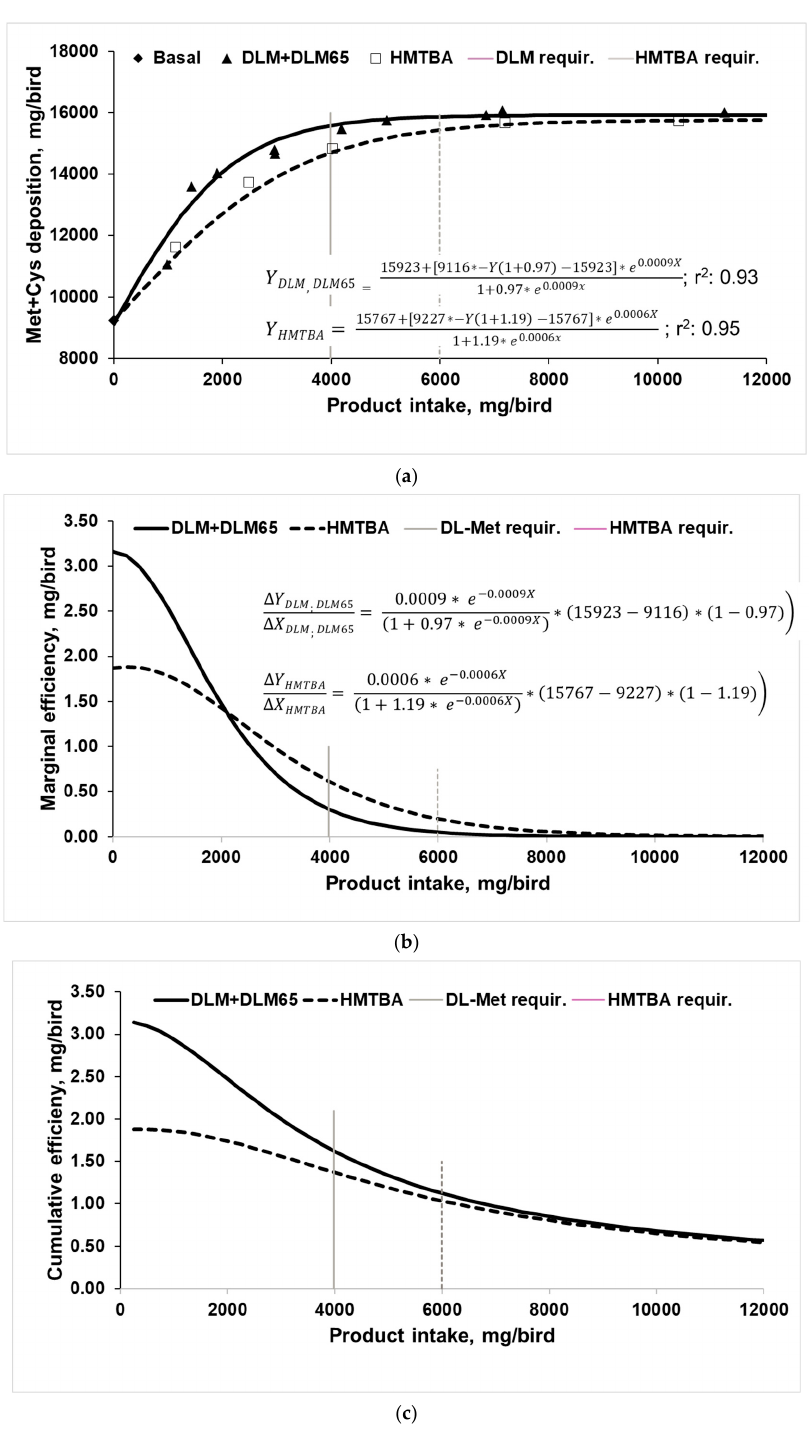
Figure 2. ( a ) Methionine + Cysteine (Met + Cys) deposition of 0–35 day old broilers fed increasing levels of DL-Methionine (treatments DLM and DLM65) and DL-2-hydroxy-4-methylthio butanoic acid (HMTBA) (A; four-parameter logistic regression analyses on replicate basis, treatment means are plotted in the diagram, required product intake for 95% of asymptotic response 3984 mg DLM and 5991 mg HMTBA); ( b ) marginal e ffi ciency of ingested products for Met + Cys deposition according to the 1st derivation of the four-parameter logistic regression equation; ( c ) cumulative e ffi ciency of ingested products for Met + Cys